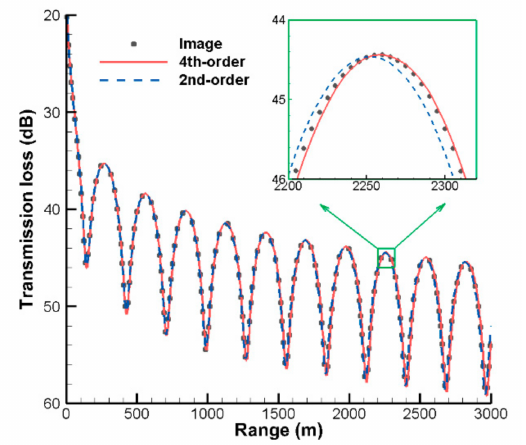
Figure 6. TL curves along the receiver line ( z = 25 m) for the ideal fluid waveguide. The TL contours and TASI streamlines obtained from the present VWI model using the 2nd- and 4th-order FD schemes are shown in Figure 7a,b, respectively, and they match well throughout the whole field. The main characteristic of the sound field is that the TASI streamlines are periodic in the range direction.